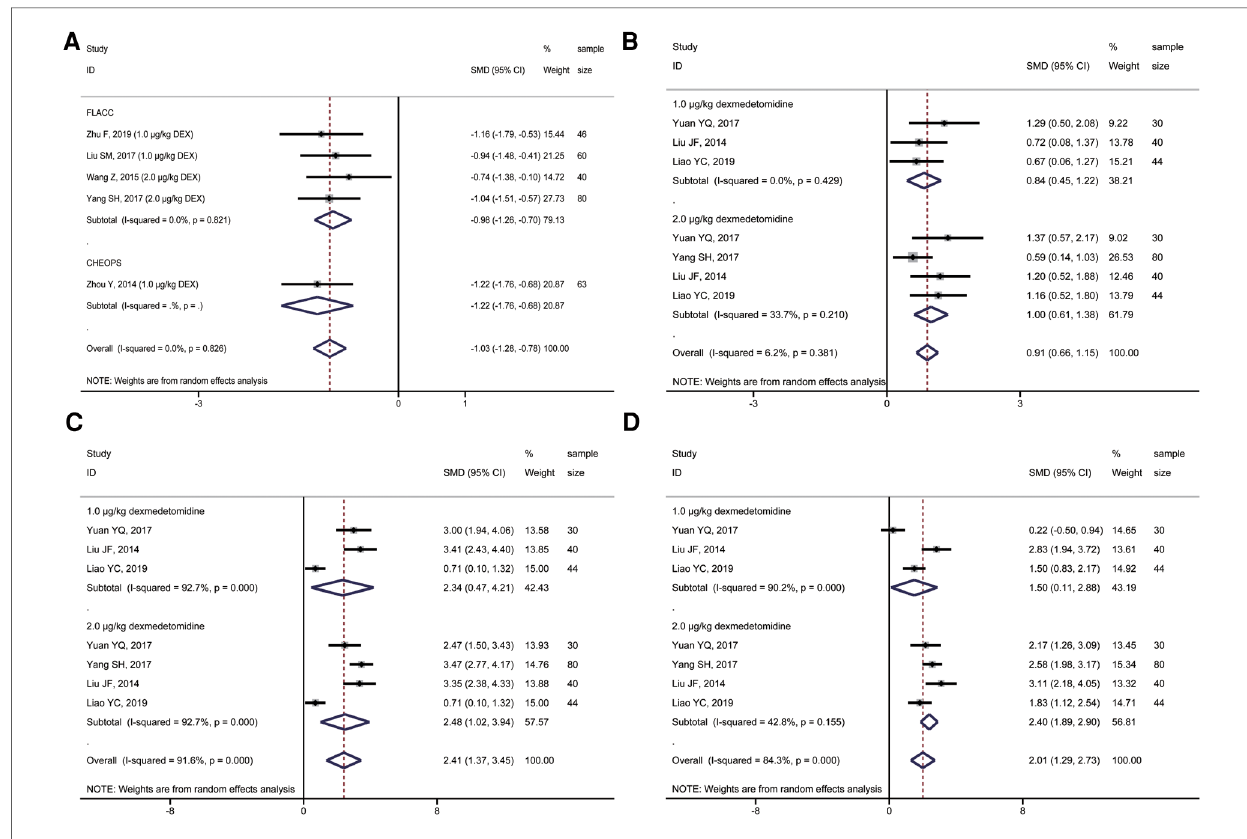
FIGURE 4 Forest plot of comparison of combined group and control group: ( A ) Pain score at 24 h (T 5 ); ( B ) Ramsay score at 2 h (T 1 ); ( C ) Ramsay score at 4 h (T 2 ); ( D ) Ramsay score at 8 h (T 3